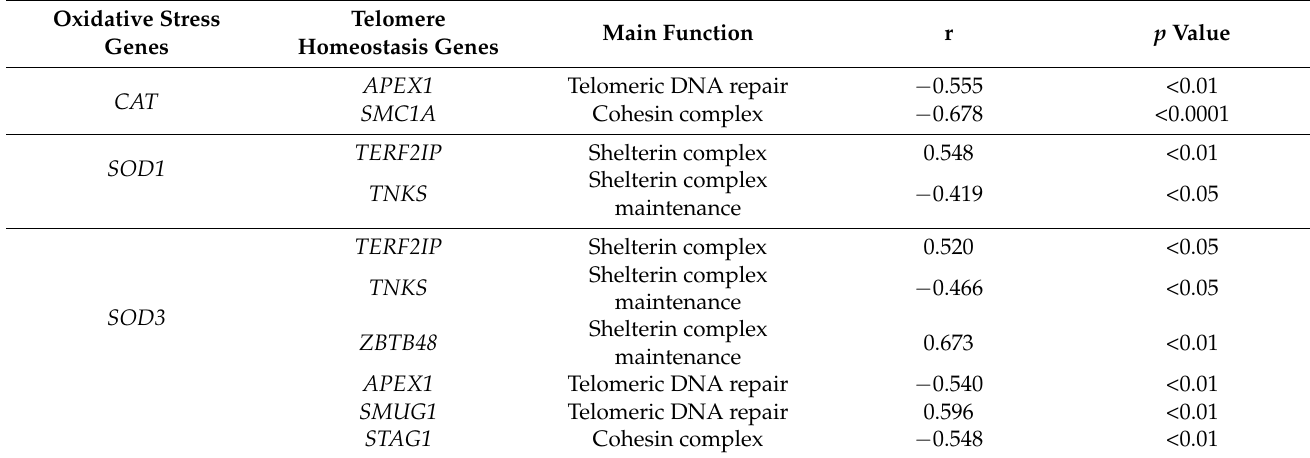
Table 2. Relationships between altered telomere homeostasis and oxidative stress genes expressed differentially in patients with ischemic